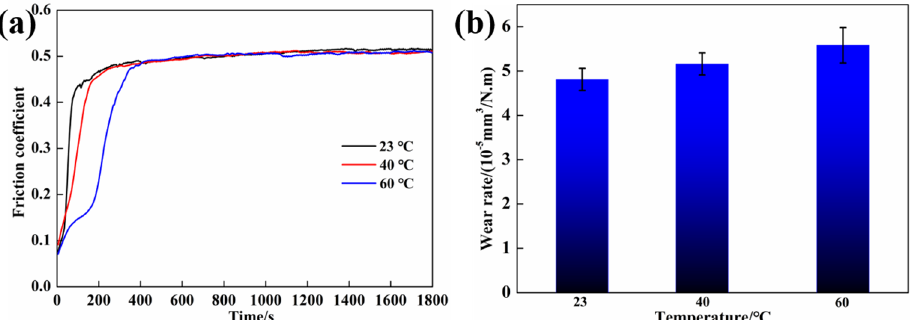
Figure 9. Tribological properties of FGr@MoS 2 -1.2 at different temperatures: ( a ) friction coefficient and ( b ) wear rate. and ( b ) wear